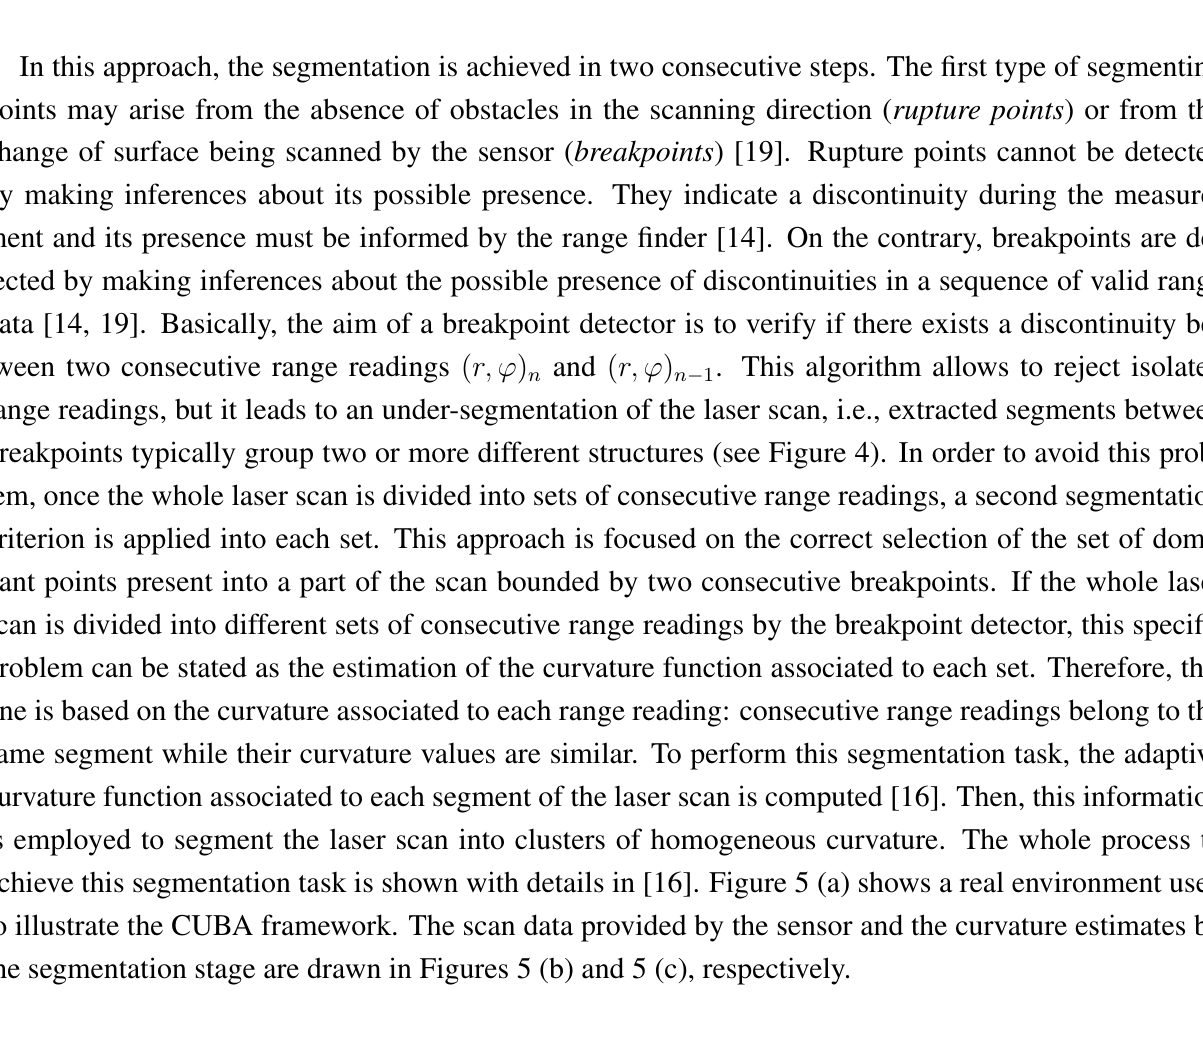
(a)–(b) Laser scan and extracted breakpoints (squares). It must be noted